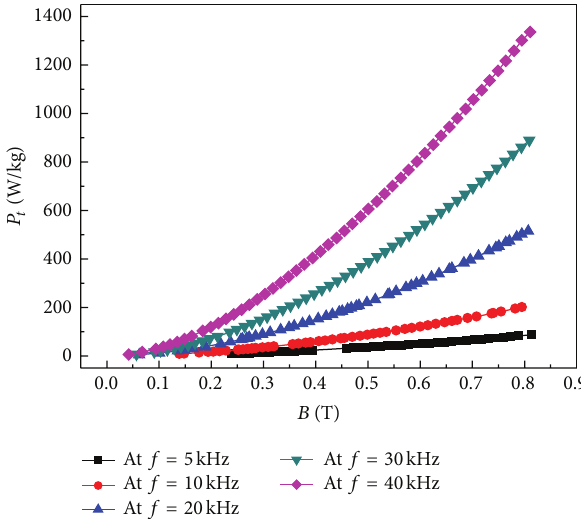
Figure 7: Core losses of melt spinned ribbons dependent on satura- tion magnetic induction ( 𝐵 ) and frequency ( 𝑓